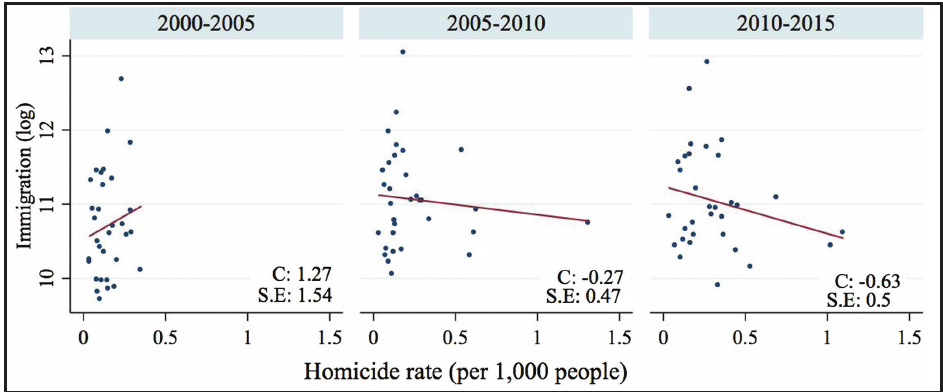
Figure 5 Immigration and homicide rates (per 1,000 people) in Mexican states, by period.